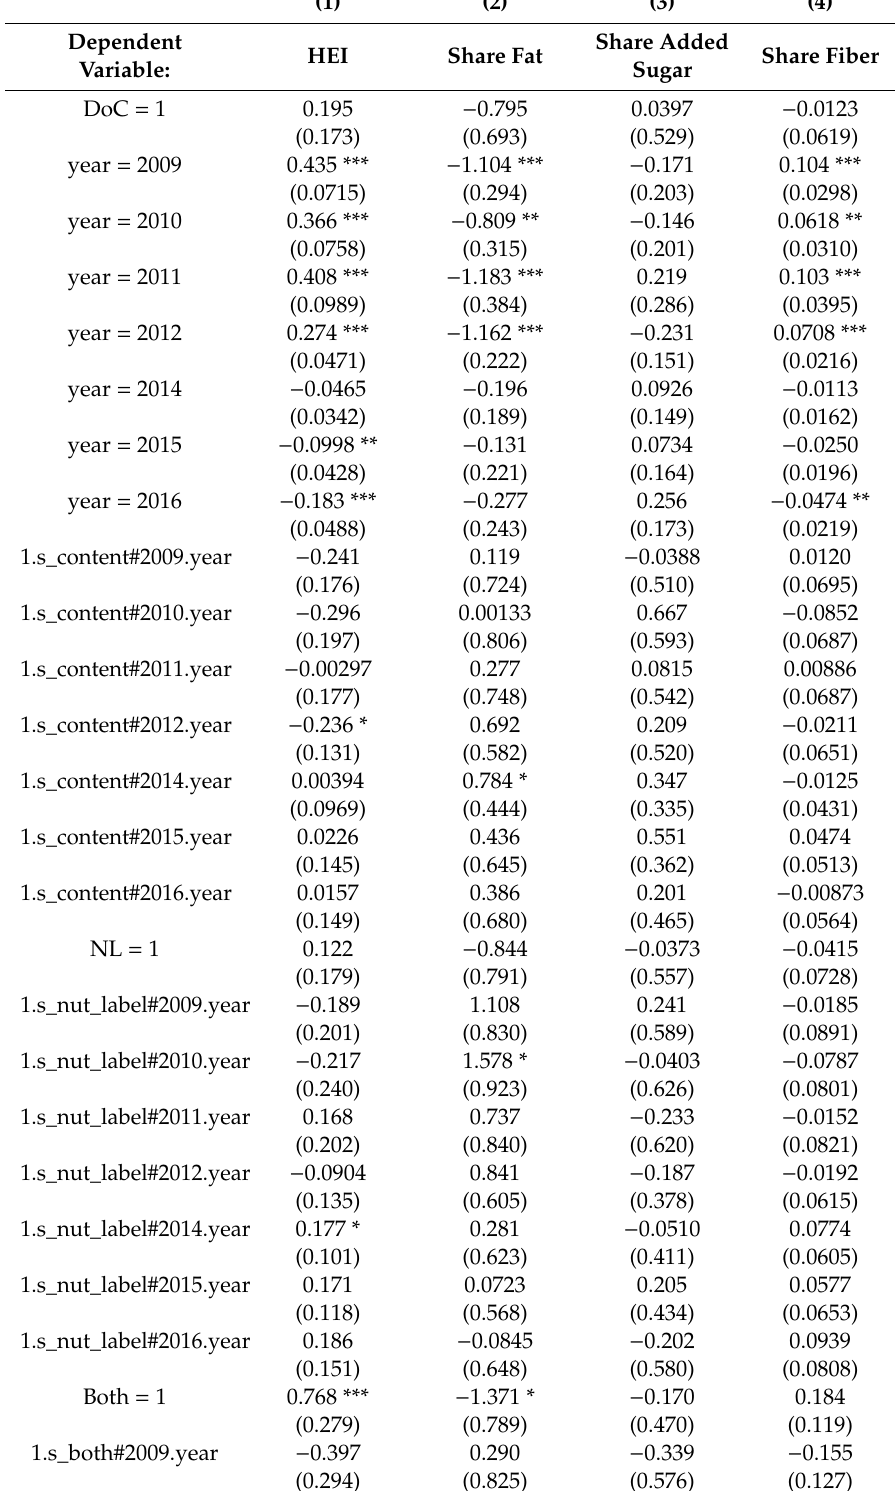
Table A9. Test of common trend of NL switchers, DoC switchers, Both switchers and extended control